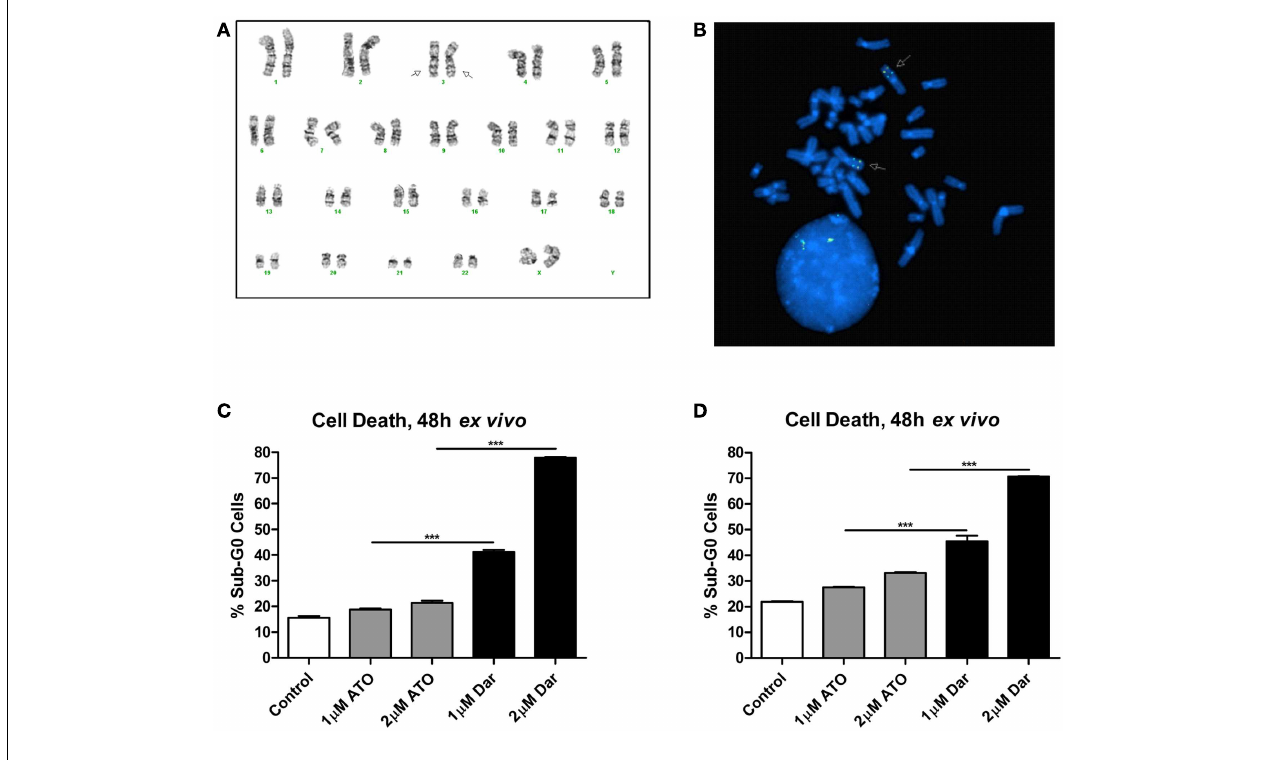
aspirate (C) and peripheral blood (D) were treated ex vivo for 48h with the indicated doses of arsenic trioxide (ATO) and darinaparsin (Dar) to assess sensitivity to arsenicals. Cell death was measured as the percentage of cells with sub-G 0 DNA content. Error bars indicate